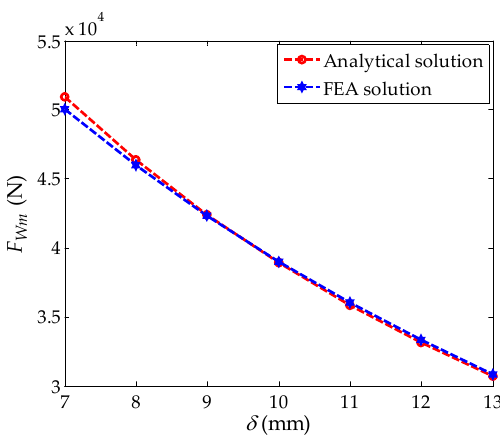
Figure 7. The peak braking force varying with the air gap length.